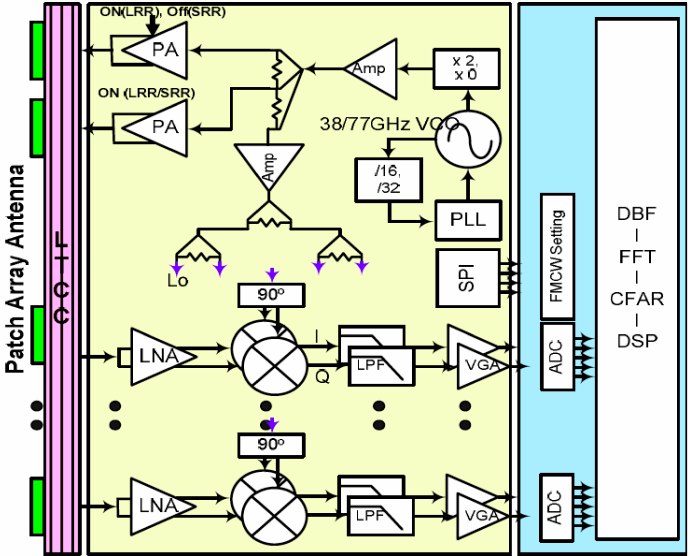
Figure 18. Block diagram of proposed CMOS centric phase array transceiver architecture for radio on a chip and radar on a package